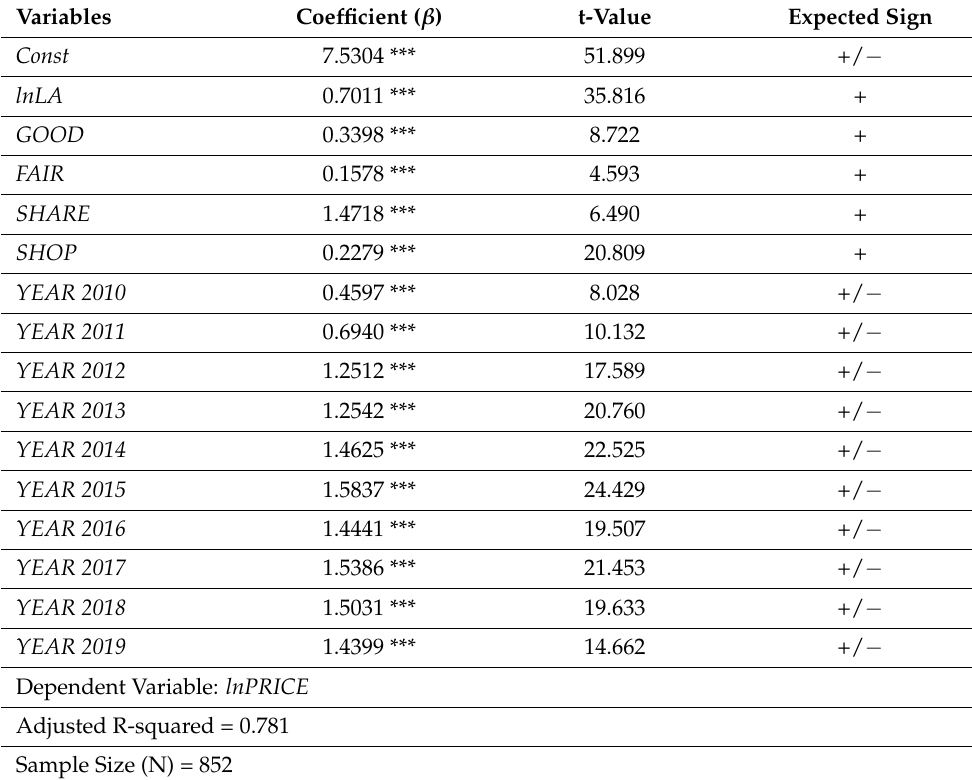
Table 4. OLS Regression Results of Model 1.